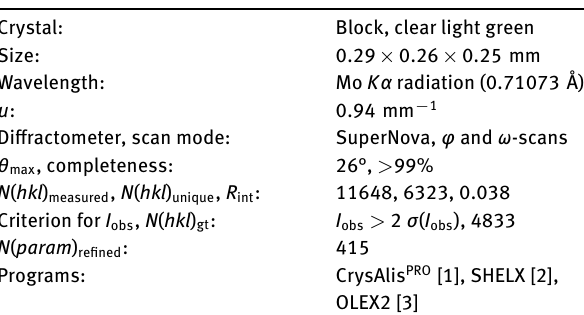
Table 1: Data collection and